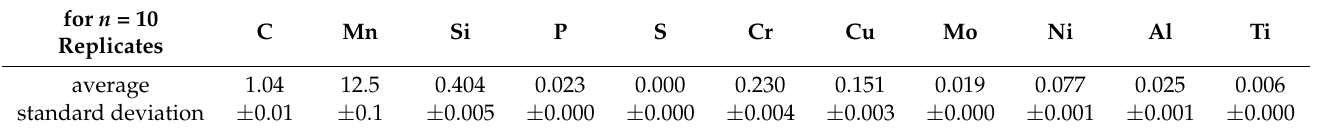
Table 1. Results of spectral analysis of the chemical composition of the steel in the as-delivered state.